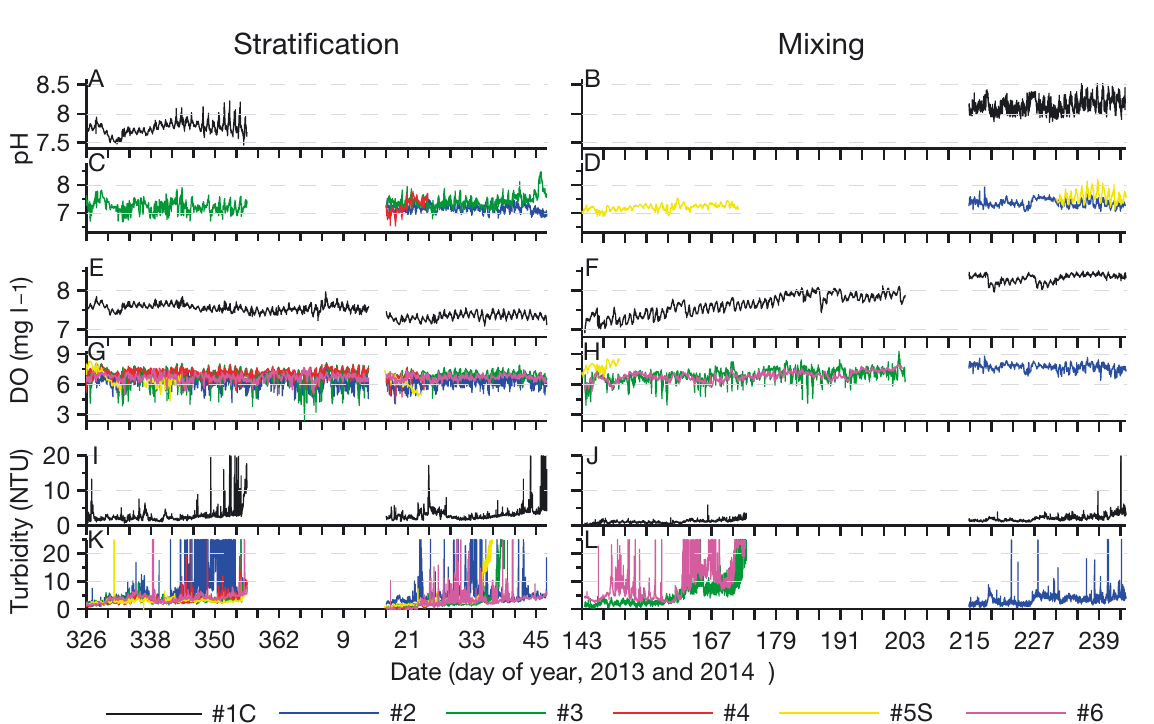
Fig. 4. Time series of (A−D) water pH, (E−H) dissolved oxygen (DO), and (I−L) turbidity for the periods of stratification (left) and mixing (right) regimes at Furnas Hydroelectric Reservoir, for (A,B,E,F,I,J) platform #1C and (C,D,G,H,K,L) platforms #2, #3, #4, #5S, and #6